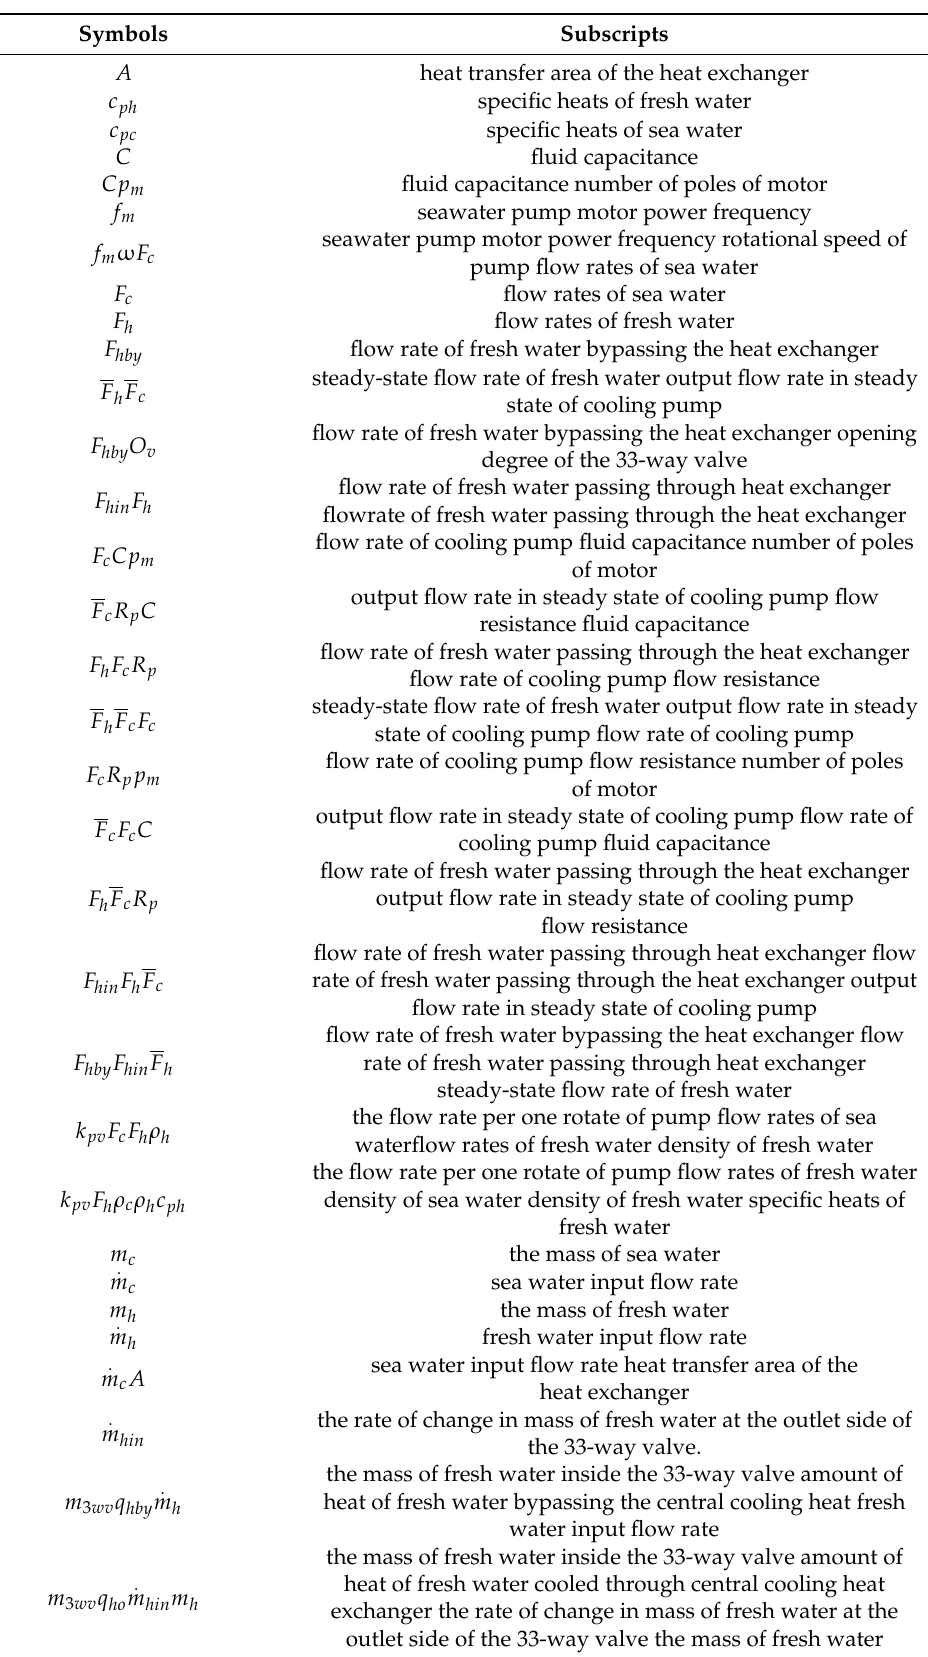
Table 2. Symbols.